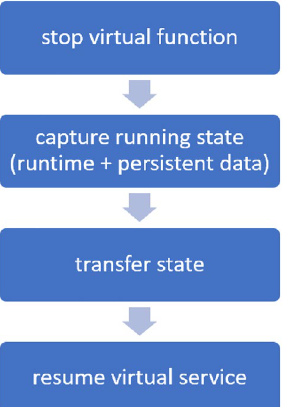
Figure 4. Hard (cold) migration